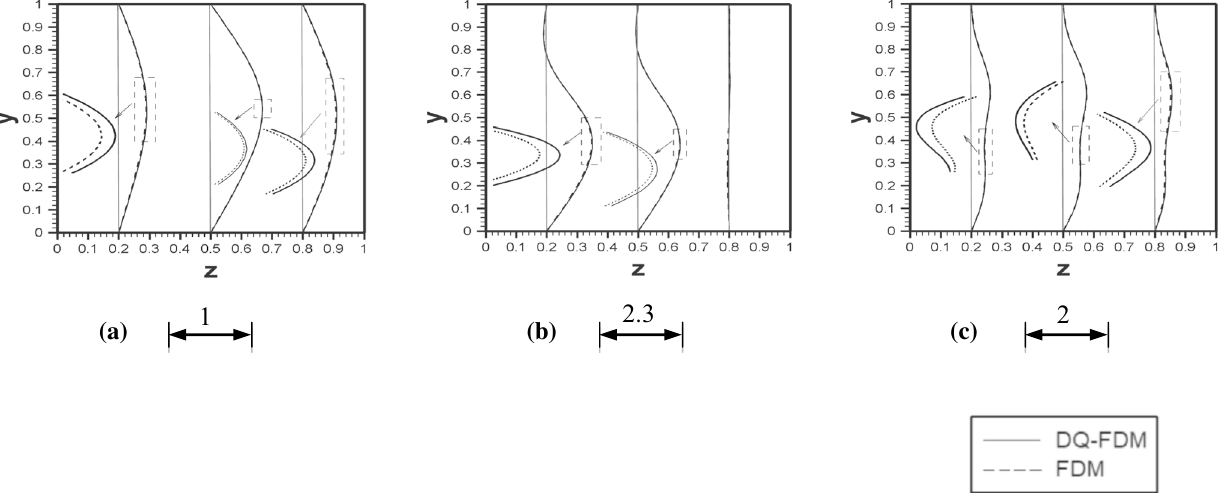
Fig. 9 A sample of comparing the distribution of the velocity of the a longitudinal ( u ), b depth ( v ) and c transverse ( w ) along the depth and for passing plate through the middle of the length (t = 0.05,